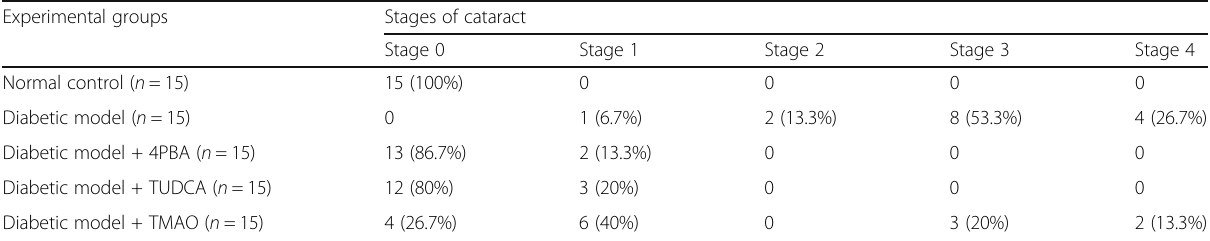
Table 1 Percentage of different stages of cataract in lenses of each group at the end of the experiment Experimental groups